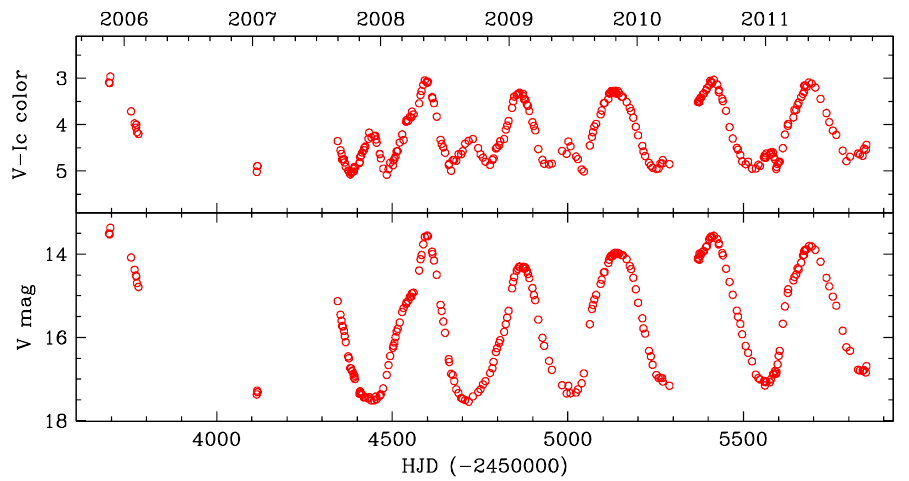
Fig. 6. The light curve of the dust-free symbiotic Mira LL Cas as monitored by the ANS telescope